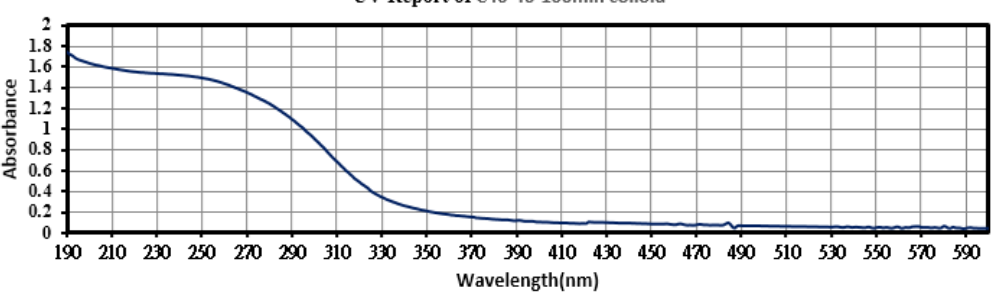
Figure 12. Absorption spectrum of C40-40-100 min colloids.